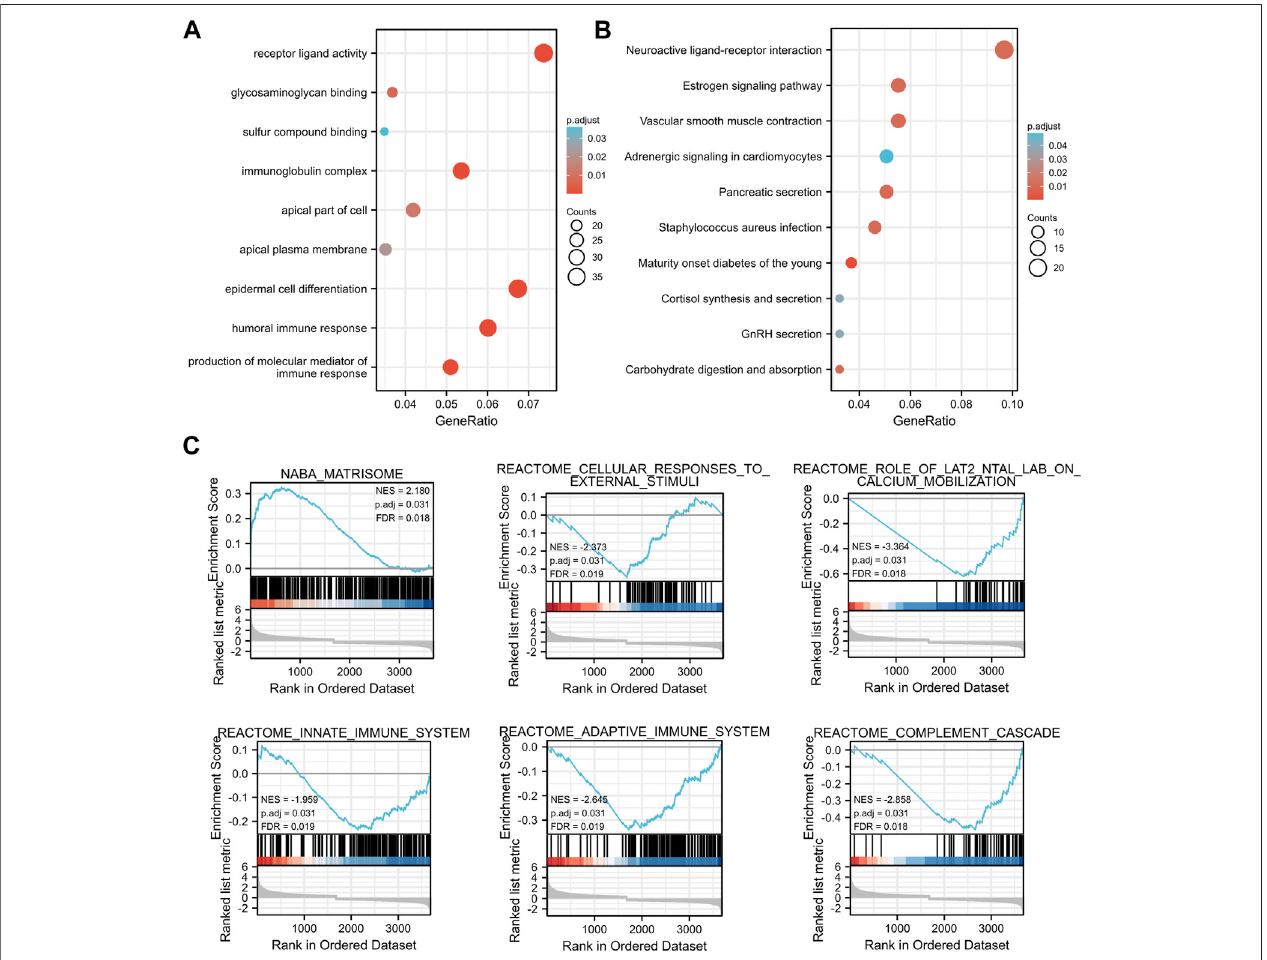
FIGURE 3 | Enrichment analysis of TMEM33-correlated DEGs in CESC. Bubble plots display the functional enrichment results by TMEM33 expression correlated DEGs in terms of biological processes, molecular functions, cellular components (A) , and KEGG signaling pathways (B) . The functional categories and pathways were annotated with color gradient bubbles of different sizes. (C) Signi fi cantly enriched pathways with p. adj < 0.05, such as matrisome, cellular responses to external stimuli, role of LAT2/NTAL/LAB on calcium mobilization, innate immune system, adaptive immune system, and complement cascade.